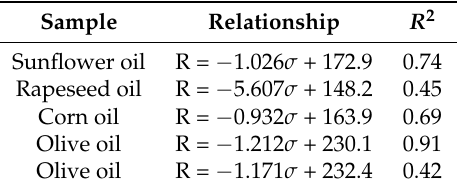
Table 4. Correlation between conductivity σ and the measured resistance using the IDE sensor and the measurement